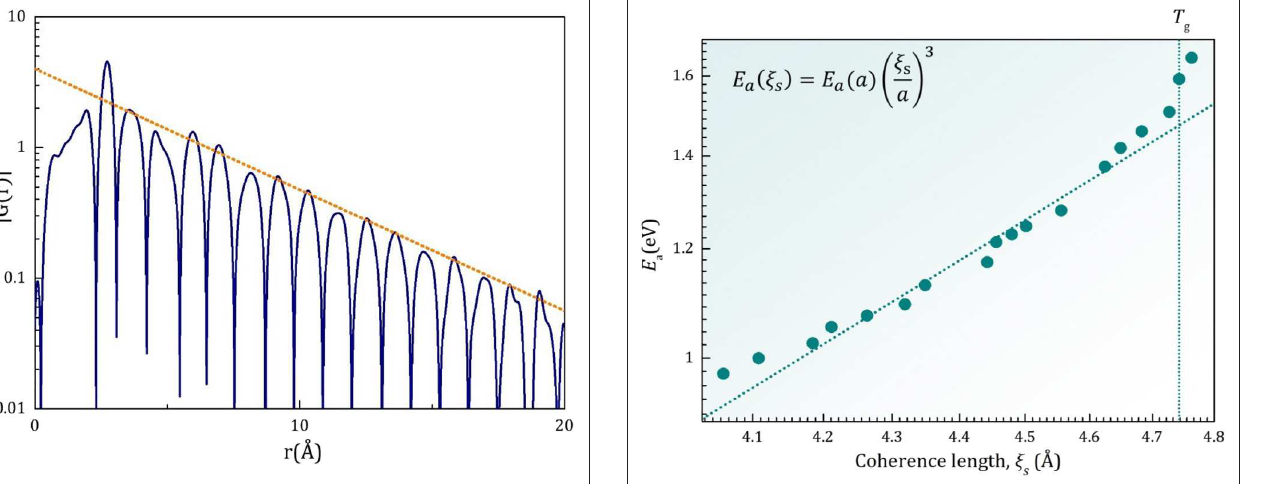
FIGURE 4 | Dependence of the activation energy for viscosity, E a ( T ), on the coherence length, ξ s (T), of density correlation [ 18].